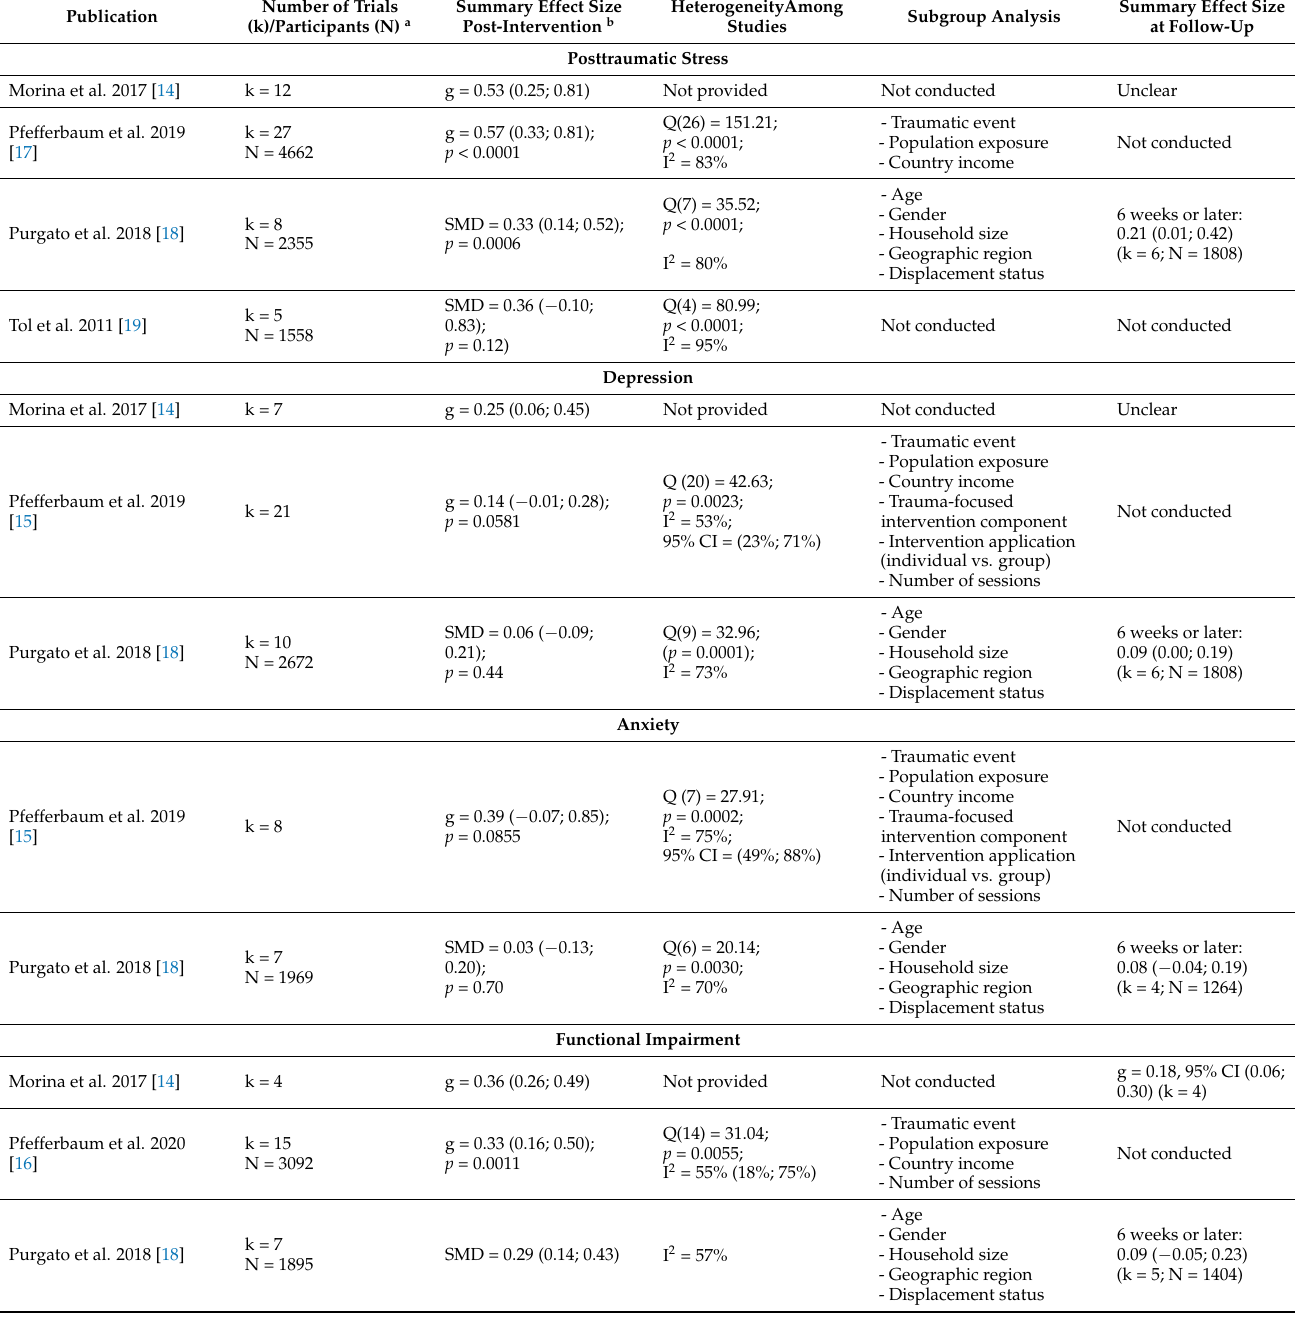
Table 1. Summary effect sizes of meta-analyses on the effectiveness of interventions on